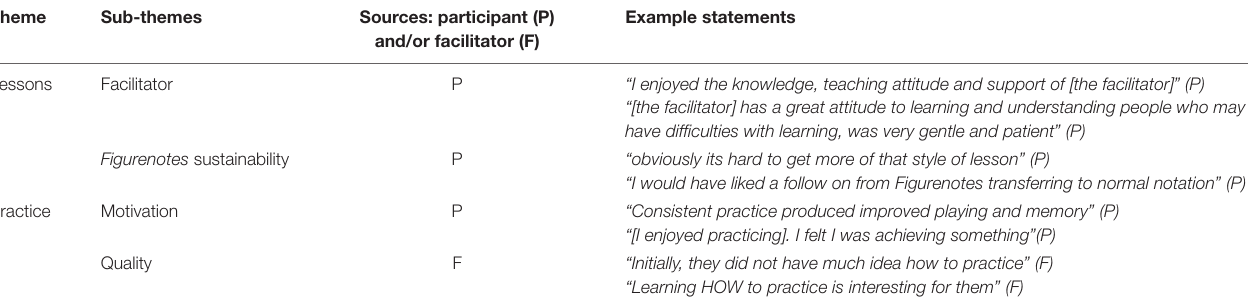
Table 6 describes the main themes of benefits with sub- themes and sample statements provided. Both the